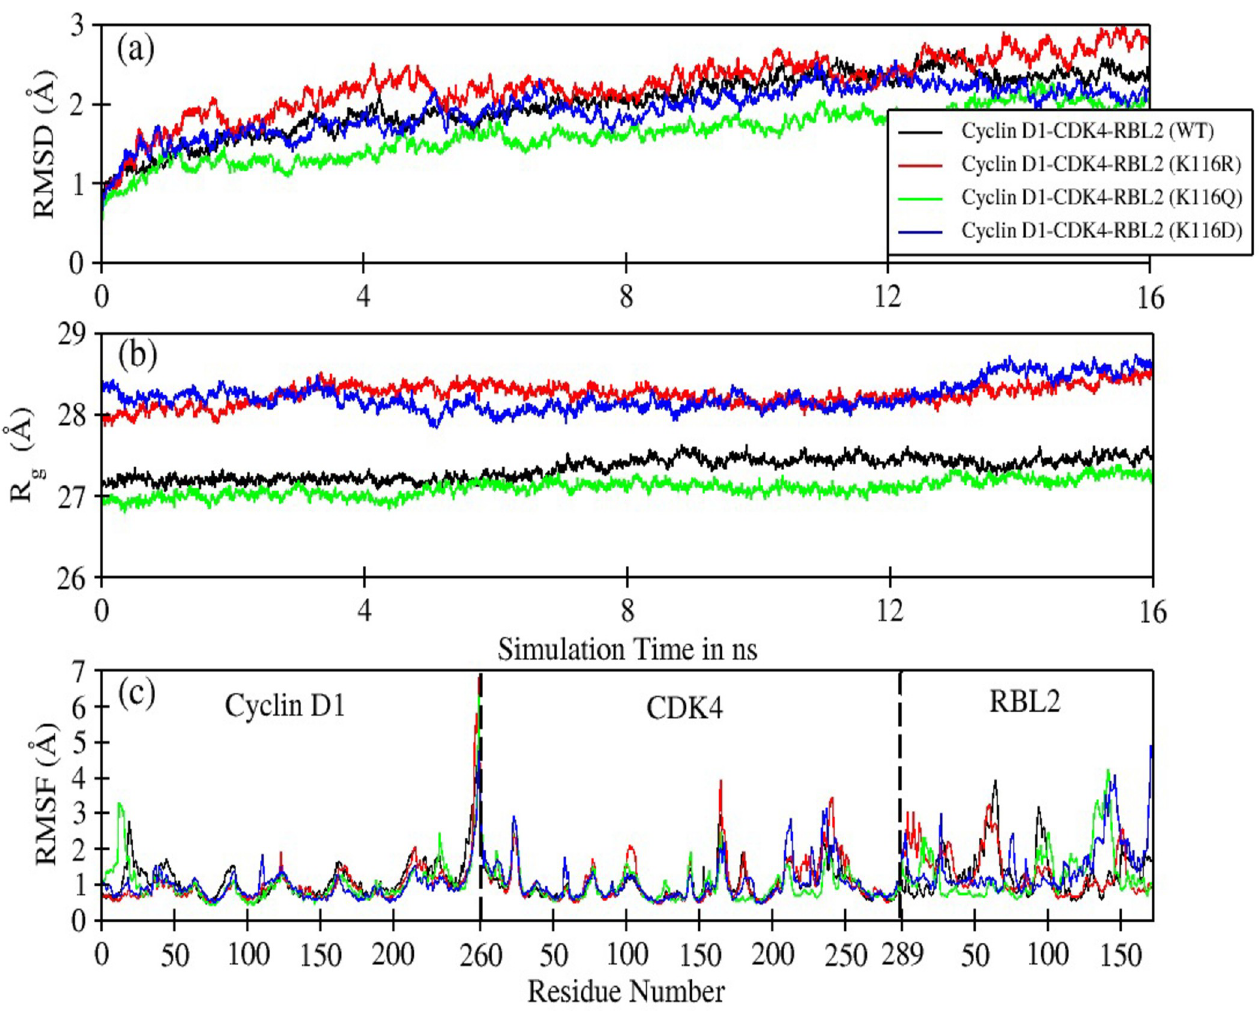
Fig 8. Root mean square deviation, RMSD (a), Radius of gyration, R g (b) and Root mean square fluctuation, RMSF (c) of wild-type (WT) and mutated Cyc- D1/CDK4 − Rbl2 protein complexes as observed over the period of 20 ns of sampling. The wild-type Cyc-D1/CDK4 − Rbl2 complex is represented as solid black, while mutated (K1083R), (K1083Q) and (K1083D) complexes are represented as red, green and blue colors, respectively. In RMSF graph (c), the amino acid regions indicating Cyc-D1, CDK4 and Rbl2 have been also